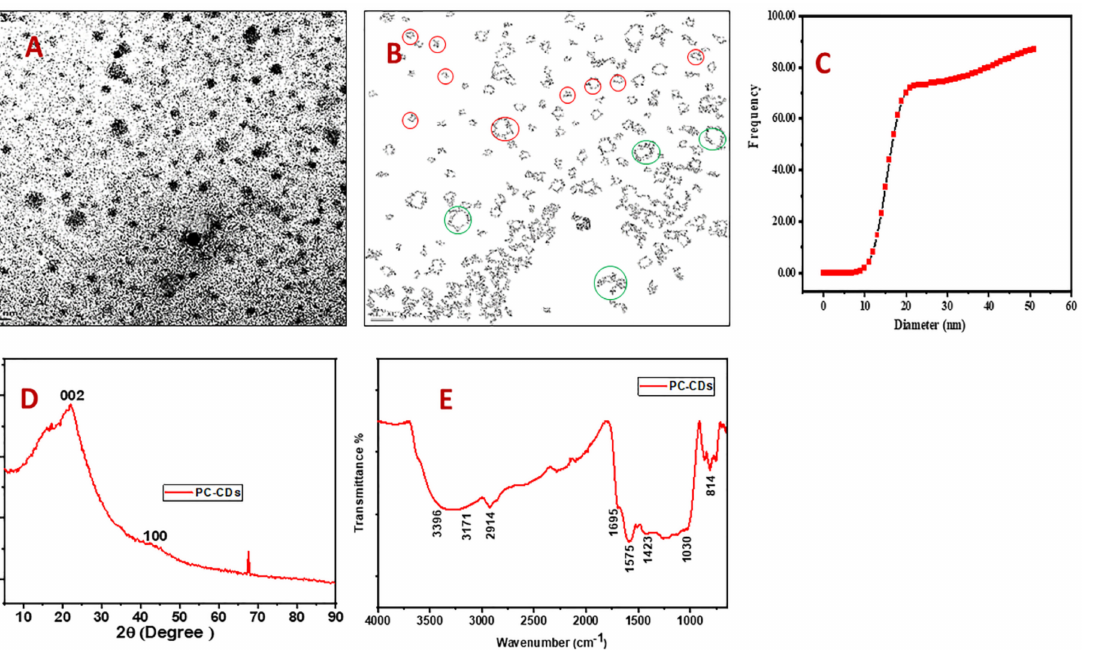
Figure 1. ( A ) TEM micrograph; ( B ) outlines of identified nanoparticles from ImageJ software analysis. These outlined areas were used to determine equivalent diameters of the particles; ( C ) particle size distribution curve; ( D ) XRD pattern; and ( E ) FTIR Spectra of synthesized